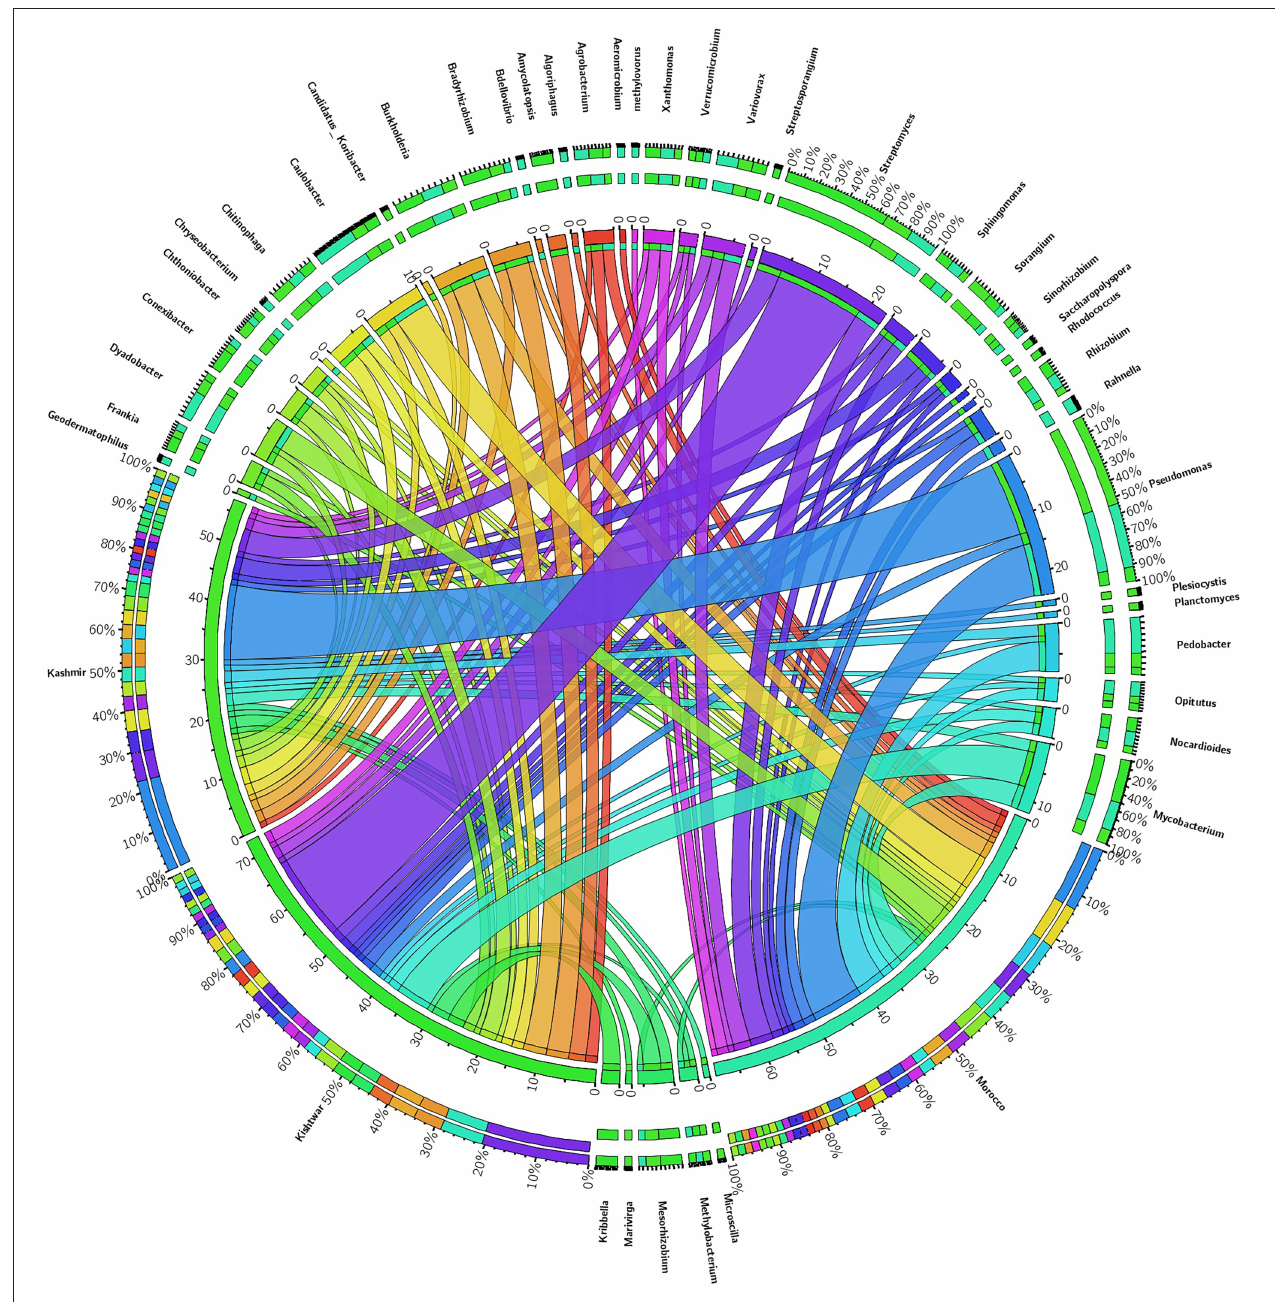
FIGURE 10 | Abundance of core genera and unique genera in three geographical locations. Central line (ribbons) represents the abundance of each genus and connects genera to samples. The outer three rings are the stacked bars representing the relative contribution of particular genera in every